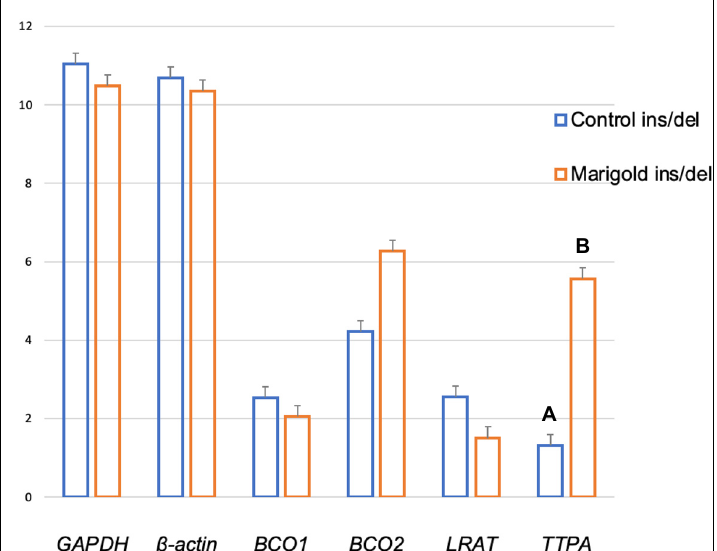
Figure 3. Relative BCO1 , BCO2 , LRAT, and TTPA mRNA levels (log2 abundance) in the perirenal fat of rabbits with the ins/del genotype at codon 248 of the BCO2 gene, fed different diets (control diet vs. a diet with the addition of Aztec marigold flower extract). GAPDH and ß-actin were used as reference genes. Data represent posterior means (expressed as arbitrary units) ± SEM (standard error of the mean). Means followed by the different superscripts (A, B) differ highly significantly ( p ≤ 0.01).